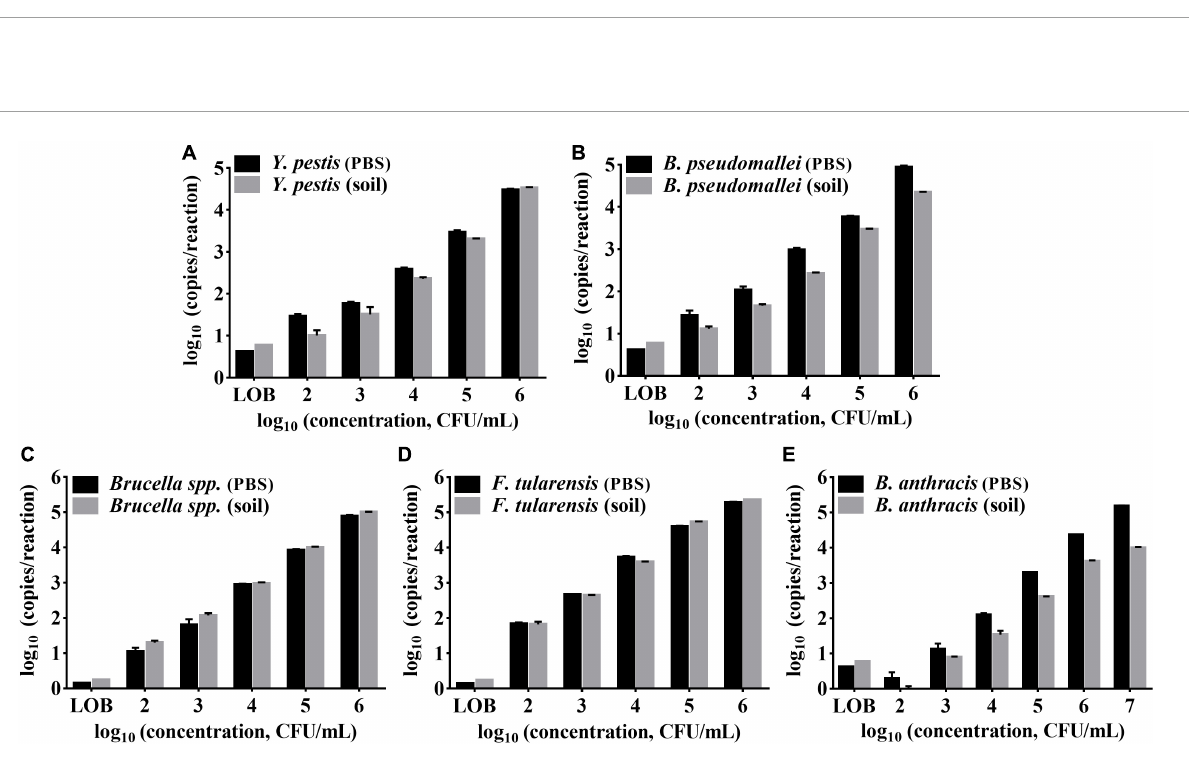
FIGURE6 Performances of the multiplex ddPCR assay detecting target bacteria in PBS solutions and soil samples. (A–E) Represents the target of Y. pestis , B. pseudomallei , B. anthracis , Brucella spp ., and F. tularensis ,respectively. The x -axis refers to log 10 (ddPCR results, copies/reaction); the y -axis refers to log 10 (bacteria concentration, CFU/mL). Each test was repeated in triplets. LOBs were determined to be 5.905 copies/reaction and 1.725 copies/reaction for the FAM and HEX channels,